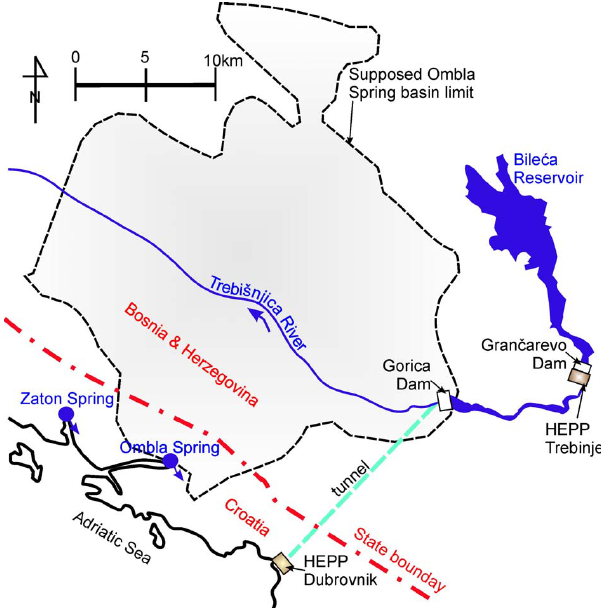
Figure 1 Fig. 1. Location map indicating the study area, the site of the Ombla Spring with its supposed catchment area, the Zaton Spring, the Tre- bišnjica River, the boundary limit between Croatia and Bosnia and Herzegovina, as well as the position of existing dams, reservoirs and